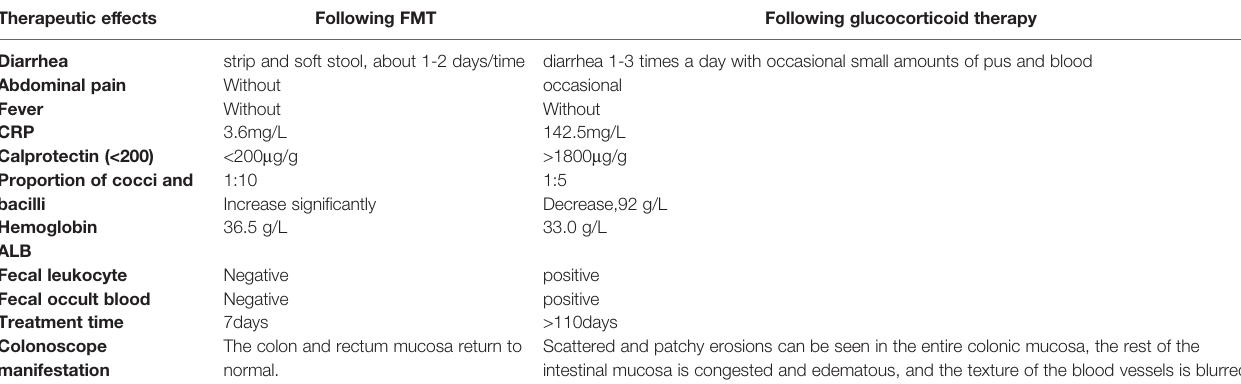
TABLE 4 | The comparison of the therapeutic effect between FMT and glucocorticoid therapy. Therapeutic effects Following